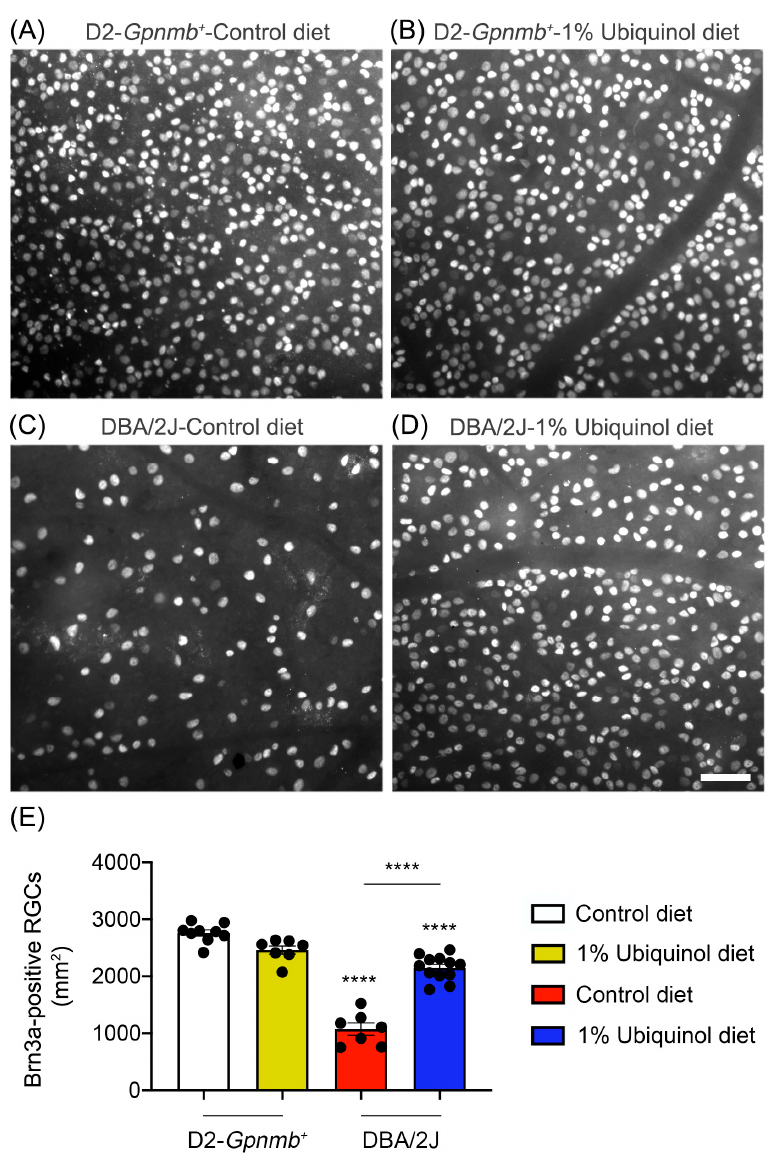
Figure 2. Effect of ubiquinol on RGC survival in glaucomatous DBA / 2J mice. ( A – D ) Retinal whole-mount immunohistochemistry using Brn3a antibody. Representative images showed Brn3a-positive RGCs in the middle areas of the retinas from each group. ( E ) Quantitative analysis of RGC survival. Data are expressed as mean ± SEM ( n = 7 retinas / group). **** p < 0.0001 (One-way ANOVA with the Bonferroni post hoc test) compared with 10 month-old D2- Gpnmb + mice supplemented with control diet. Scale bar 100 μ m.